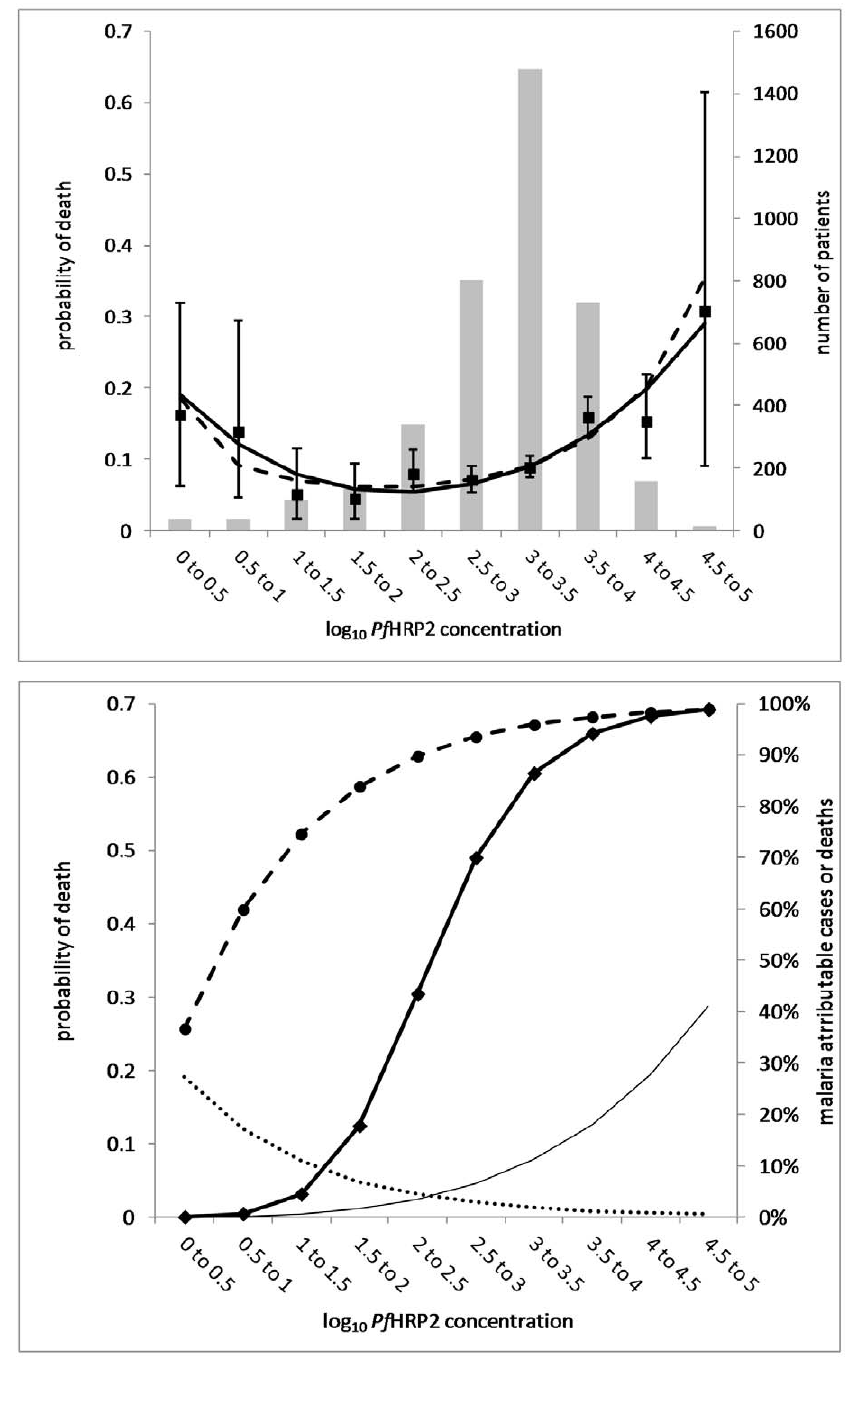
Figure 1. Observed and modelled malaria-attributable mortality and morbidity according to plasma Pf HRP2 concentrations. (Top graph) Observed number of patients (grey bars, n=3,826) and observed probability of death (squares with 95% CI error bars, n=381) according to Pf HRP2 half-log10 strata. The statistical polynomial regression model (dashed line) and the mechanistic model (black line) show the probability of death according to Pf HRP2 half-log10 strata. For a detailed description of the mechanistic model see Text S2. (Bottom graph) Malaria-attributable mortality and morbidity according to plasma Pf HRP2 concentrations. The curve derived from the mechanistic model (top) describing the relationship between log10 plasma Pf HRP2 concentration and probability of death has been deconvoluted in two separate functions: (1) Non[en-dash]malaria- attributable probability of death (dotted line, left axis), which describes the negative exponential probability of dying from non-malaria illness with increasing plasma Pf HRP2 concentrations, at a constant Pf HRP2 independent case fatality rate of 30%. (2) Malaria-attributable probability of death (thin solid line, left axis), which describes the exponential increase in the probability of death with increasing plasma Pf HRP2 concentration, a